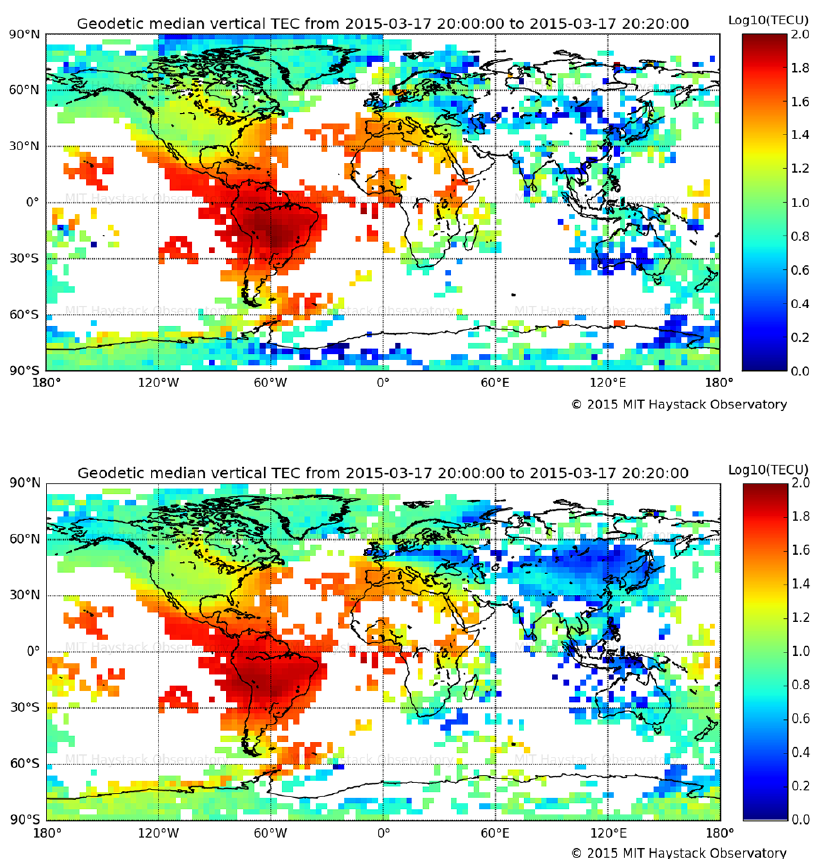
Figure 6. Global TEC map produced using two different methods for the St. Patrick’s Day storm on 17 March 2015. Top: a map produced with the MAPGPS method. Bottom: a map produced with the new WLLSID bias determination